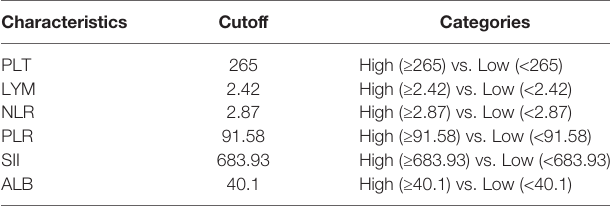
TABLE 2 | The cutoff value of in fl ammation-related factors in external application cohorts.